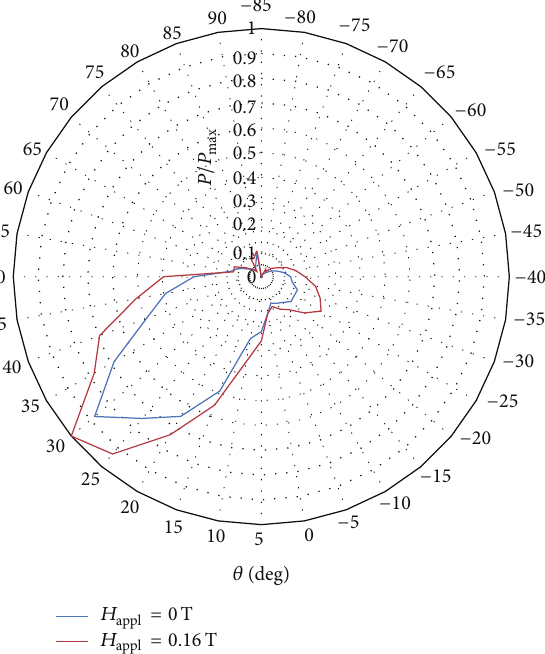
Figure 9: Radiation characteristic of the CRLH antenna on ferrite with and without magnetic biasing